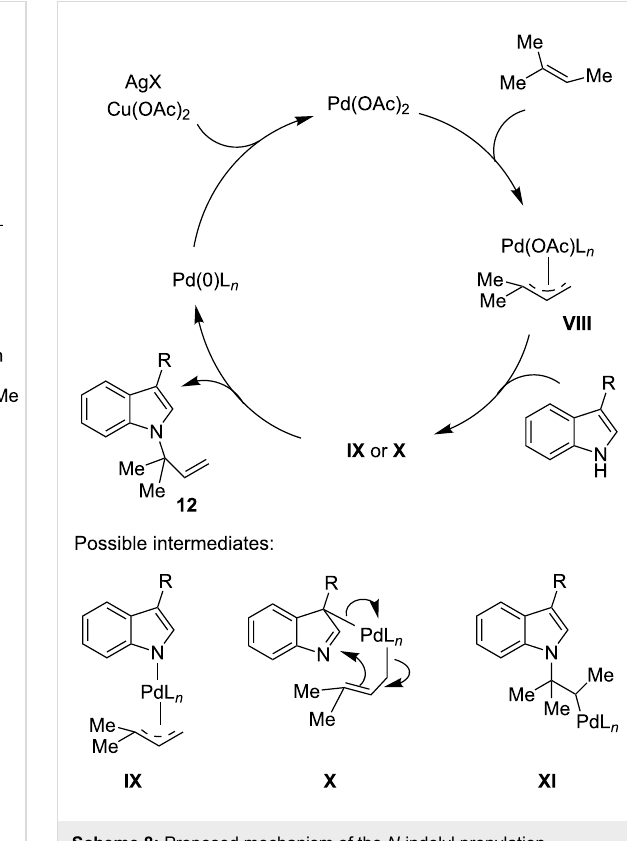
Scheme 8: Proposed mechanism of the N -indolyl